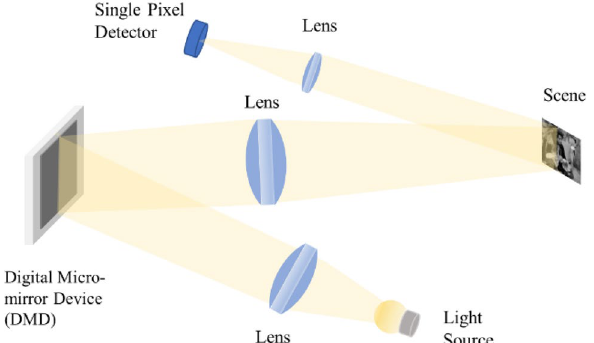
Figure 2. The SPC imaging setup. Halogen light is projected onto the DMD, from which structured light patterns are projected on the scene. A separate single-pixel detector collects the projected light from the